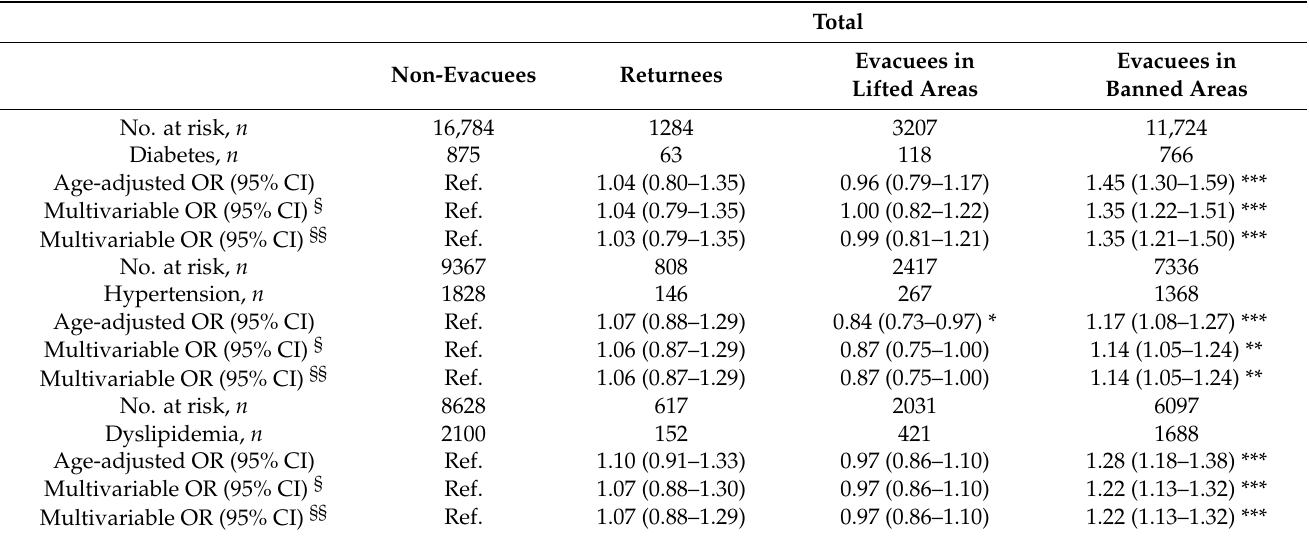
Table 2. Age-adjusted and multivariable odds ratios of diabetes, hypertension, and dyslipidemia according to evacuation